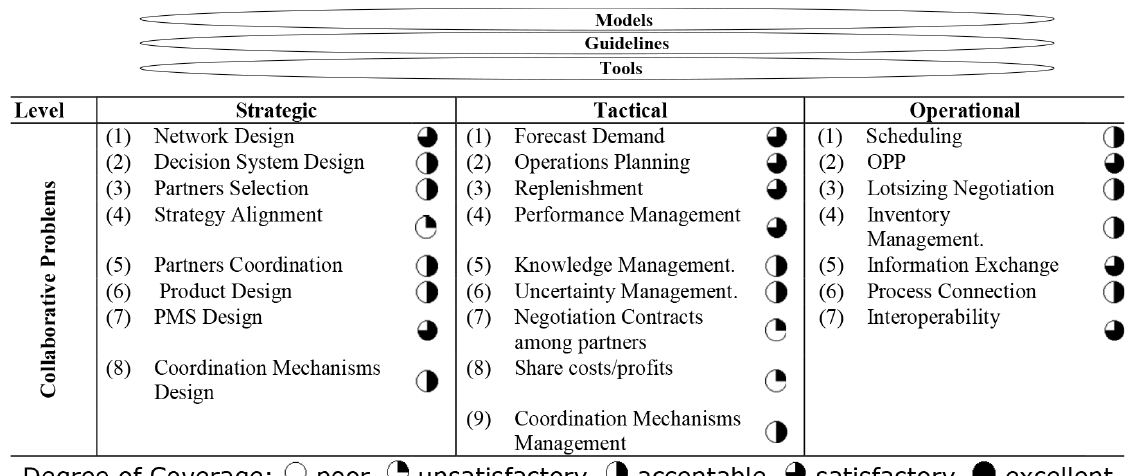
Table 1. Collaborative Network Problems (Andrés & Poler, 2011)